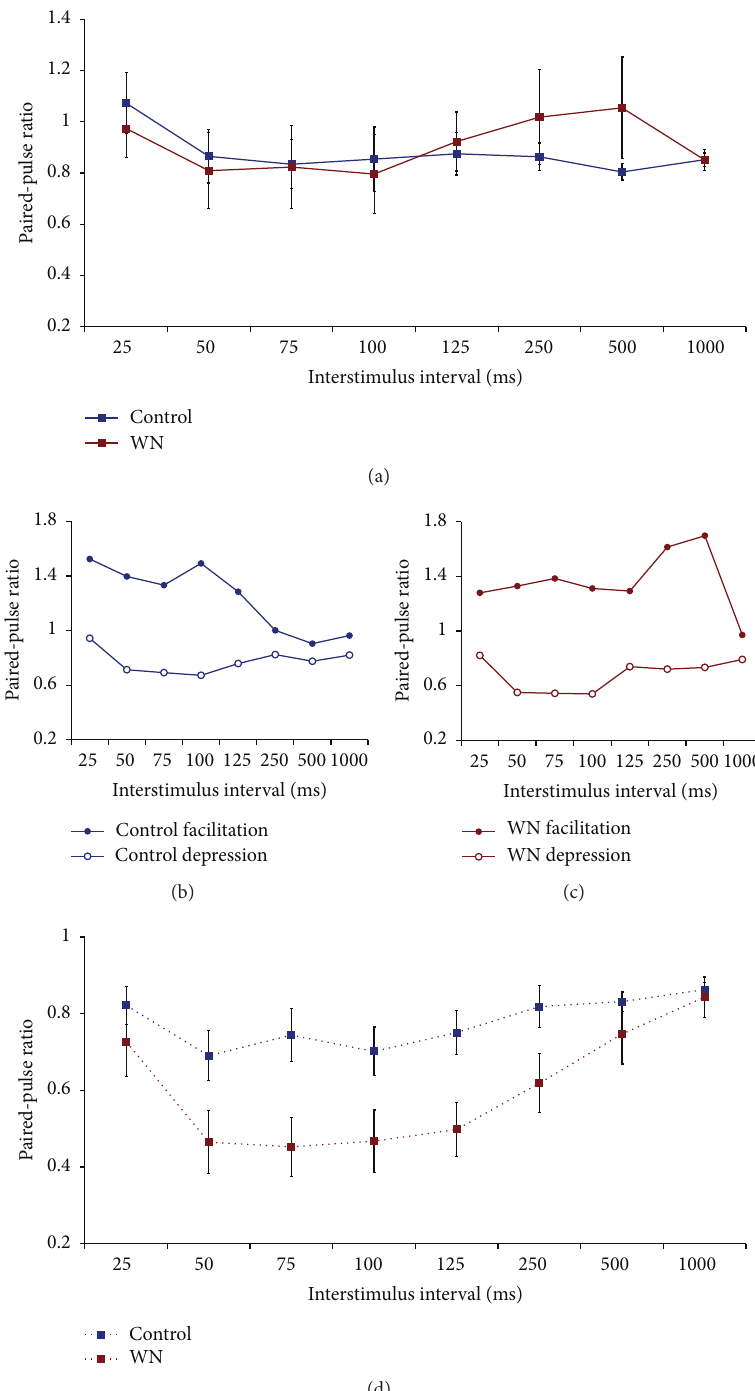
Figure 4: The effect of WN rearing on paired-pulse responses before (a, b, c) and after (d) LTP induction. (a) There was no significant effect of rearing condition on paired-pulse responses before LTP induction. As groups, both WN and control rats showed little evidence of PPD or PPF. ANOVA results for (a): effect of ISI, F (2.43, 38.88) = 1.78, 𝑃 > 0.05 ; effect of condition, F (1, 16) = 0.04, 𝑃 > 0.05 ; effect of ISI by condition interaction, F (2.43, 38.88) = 1.29, 𝑃 > 0.05 . (b) However, detailed analyses of responses in individual rats revealed that the majority ( 𝑛 = 7 , control depression) of control rats exhibited PPD, with the remaining rats ( 𝑛 = 2 , control facilitation) showing substantial PPF, which largely cancelled out the depression seen in the majority of control rats. (c) Similarly, most WN rats ( 𝑛 = 6 , WN depression) showed clear PPD, and only a minority ( 𝑛 = 3 , WN facilitation) exhibited PPF (note that panel (a) depicts the group means of data plotted in (b) and (c)). (d) Following LTP induction, both groups exhibited clear PPD. Further, WN-reared rats showed greater levels of PPD than those seen in control animals. ANOVA results for (b): effect of ISI, F (3.05, 48.84) = 10.57, 𝑃 < 0.001 ; effect of condition, F (1, 16) = 6.21, 𝑃 < 0.05 ; effect of ISI by condition interaction, F (3.05, 48.84) = 2.13, 𝑃 > 0.05